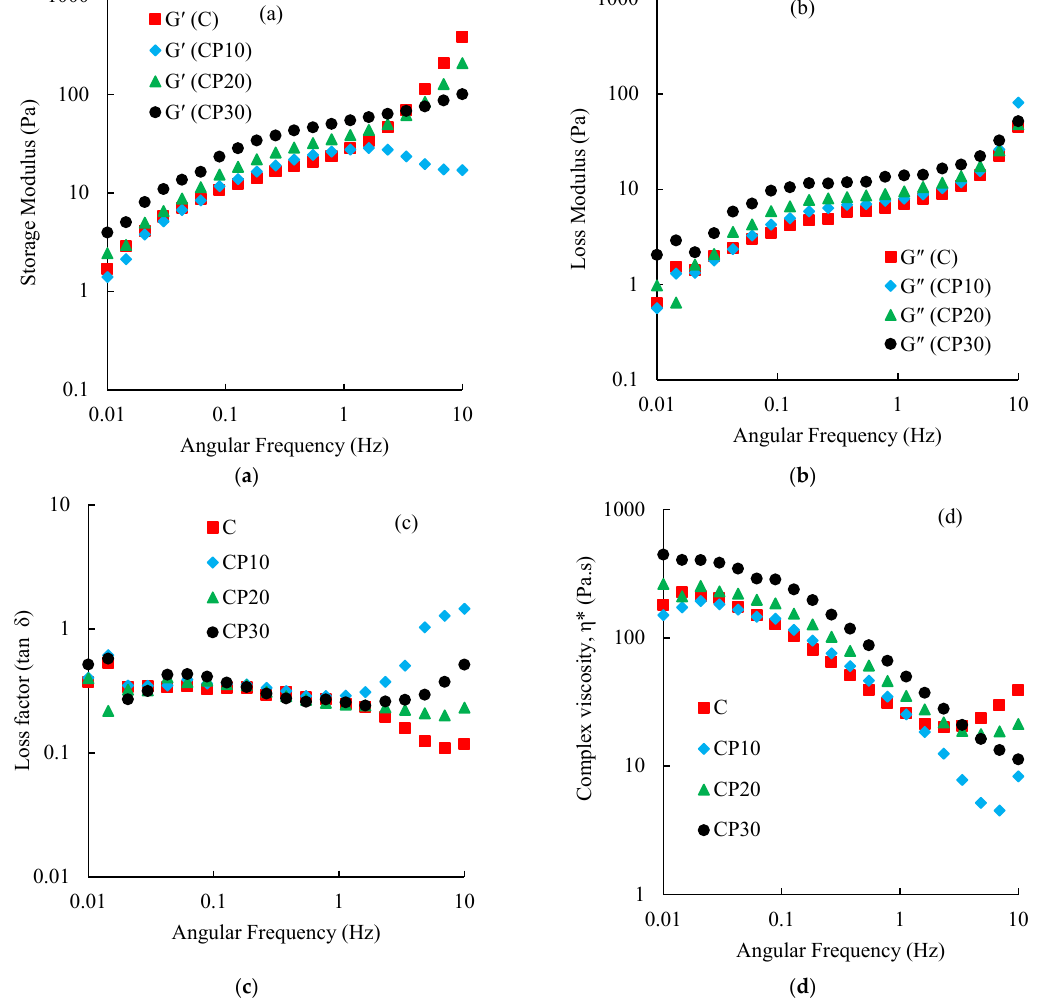
Figure 7. Changes in the storage modulus ( a ), loss modulus ( b ), loss factor ( c ), and complex viscosity ( d ) of different BSG dispersions (0.3%) at 20 °C as a function of angular frequency; C, CP 10 , CP 20 , and CP 30 indicate unmodified samples and those treated by CP for 10, 20, and 30 min, respectively.